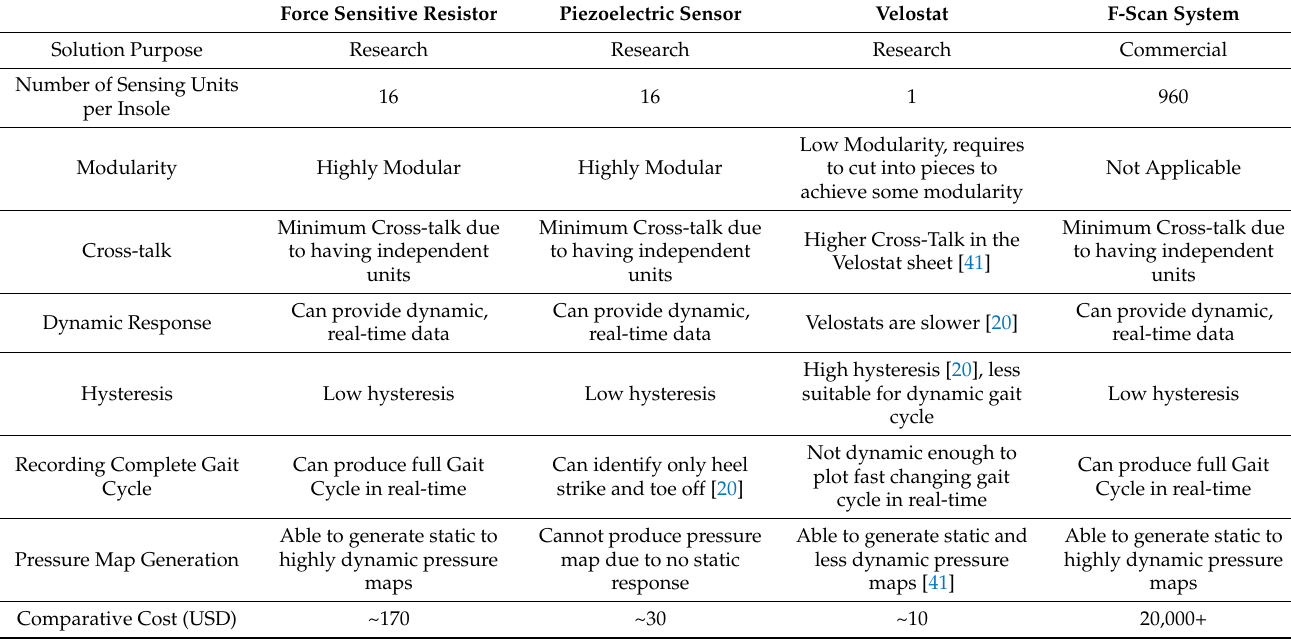
Table 1. Comparison between FSR, Piezoelectric and Velostat sensor with commercial